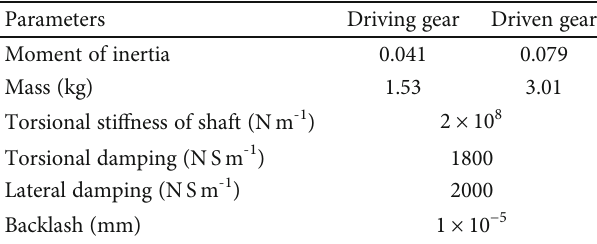
Figure 6: Meshing sti ff ness of pitting gear with di ff erent degrees calculated by the FEM method.